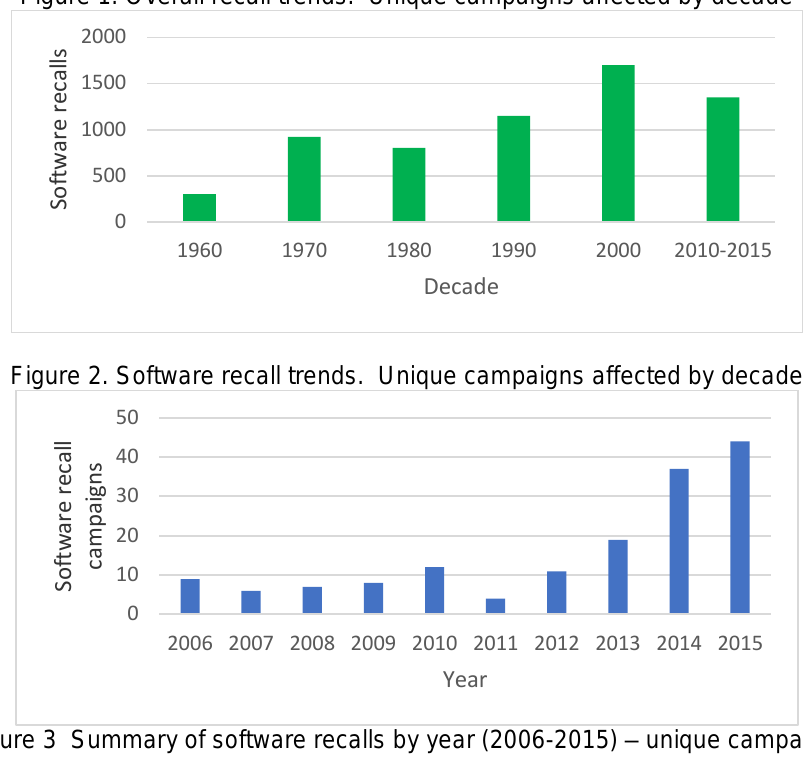
Figure 1. Overall recall trends. Unique campaigns affected by decade